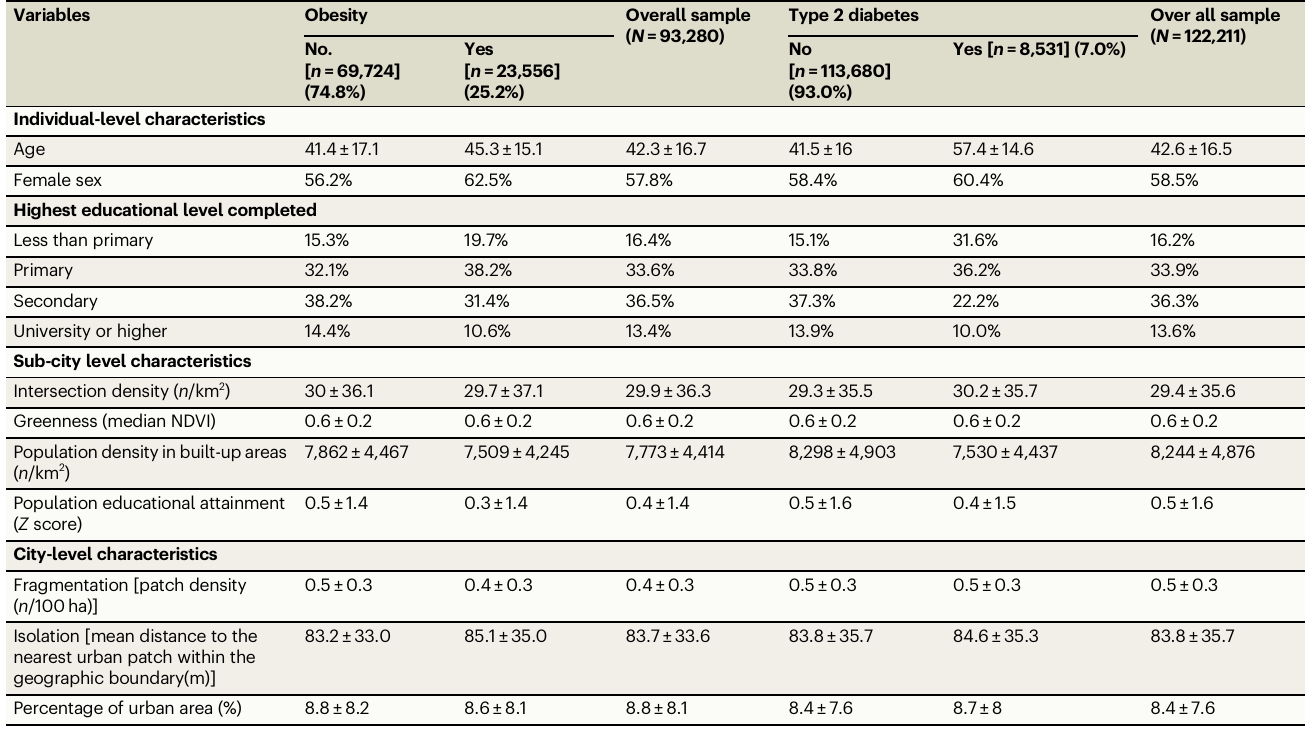
Table 1 | Characteristics of the study sample by obesity and type 2 diabetes status Variables Obesity Overall sample